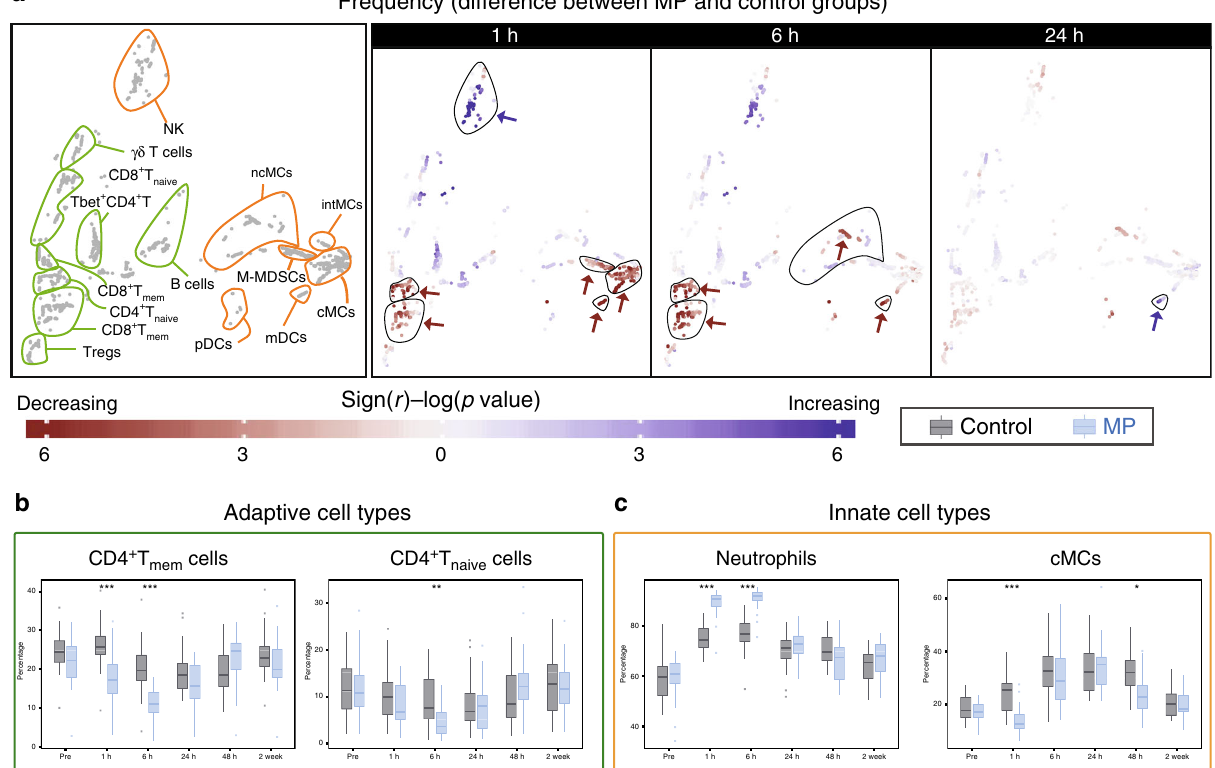
Fig. 3 Alteration of innate and adaptive immune cell frequencies by MP. a Immune cell atlas depicting differences in cell frequency between the MP and control groups at 1, 6 and 24 h after surgery (expressed as % of CD45 + mononuclear cells, with the exception of neutrophils, which are expressed as % of total live cells). Cell clusters are color-coded according to the directional differences between the control ( n = 30 patients) and MP ( n = 28 patients) group. Directional differences were computed using a two-sided Wilcoxon rank-sum test (sign(r) -log( p -value), blue/red indicating an increased/ decreased frequency in the MP group; arrows point at cell clusters that differ most signi fi cantly between the patient groups). In cell clusters of the adaptive immune compartment (contoured in green), MP treatment resulted in decreased frequencies of CD4 + T mem at 1 and 6 h and CD4 + T naïve cells at 6 h, but no signi fi cant changes in CD8 + T or B cell frequencies. In cell clusters of the innate immune compartment (contoured in orange), MP treatment resulted in decreased frequencies of cMCs and M-MDSCs at 1 h, and ncMCs and mDCs at 1 and 6 h. In contrast, MP resulted in increased frequencies of CD56 lo CD16 + NK cells at 1 h and mDCs at 24 h. b , c Box-plots depicting the frequency of manually gated immune cell subsets corroborating observations contained in the immune cell atlas. Immune cell subsets for which MP ’ s effect on adaptive ( b ) and innate ( c ) immune cell frequencies were most pronounced (CD4 + T mem , CD4 + T naive , cMCs) are shown. Neutrophil frequencies (not included in the immune cell atlas) are also shown. Box plots for all manually gated immune cells are available in Supplementary Fig. 4. All boxplots show median values, interquartile range, whiskers of 1.5 times interquartile range. (Two- sided Wilcoxon rank-sum test, * p < 0.01, ** p < 0.001, *** p < 0.0001). Exact p -values are available in Supplementary Table